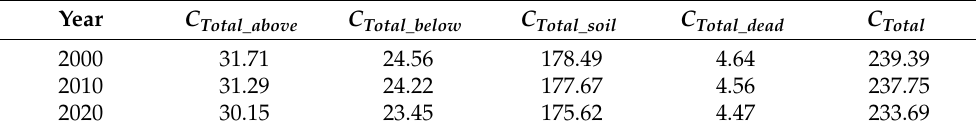
Figure 5. Spatial variation in carbon storage in Hangzhou from 2000 to 2020. Table 8. Carbon storage in Hangzhou from 2000 to 2020 (unit: 10 6 t).